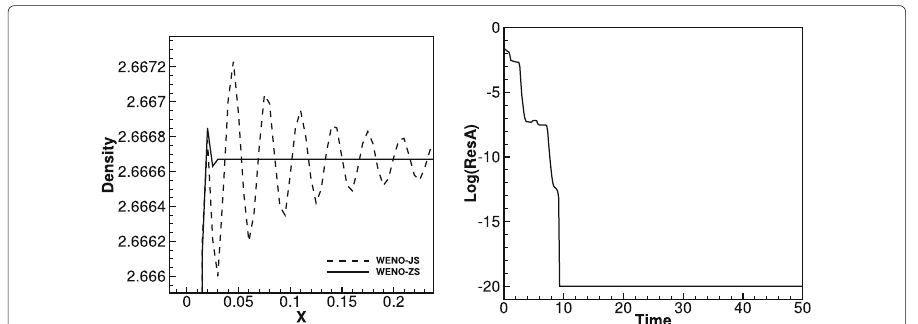
Fig. 6 The numerical solution of the 1D steady shock wave with Mach number M ∞ = 2 using the fifth-order WENO scheme with the new smoothness indicator (39). Left: zoomed density distribution downstream of the shock wave and its comparison with the traditional WENO scheme. WENO-JS represents the numerical result of the traditional WENO scheme [6]. WENO-ZS represents the result from the WENO scheme with the new smoothness indicator. Right: the time evolution of the average residue of